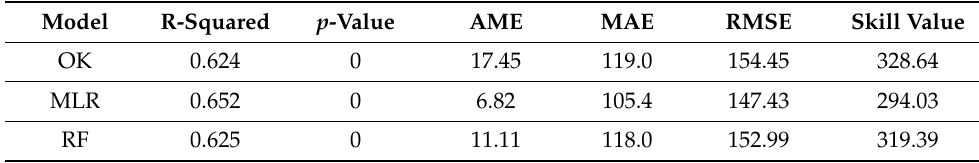
Table 6. Various Model Results on Validation data (78,000